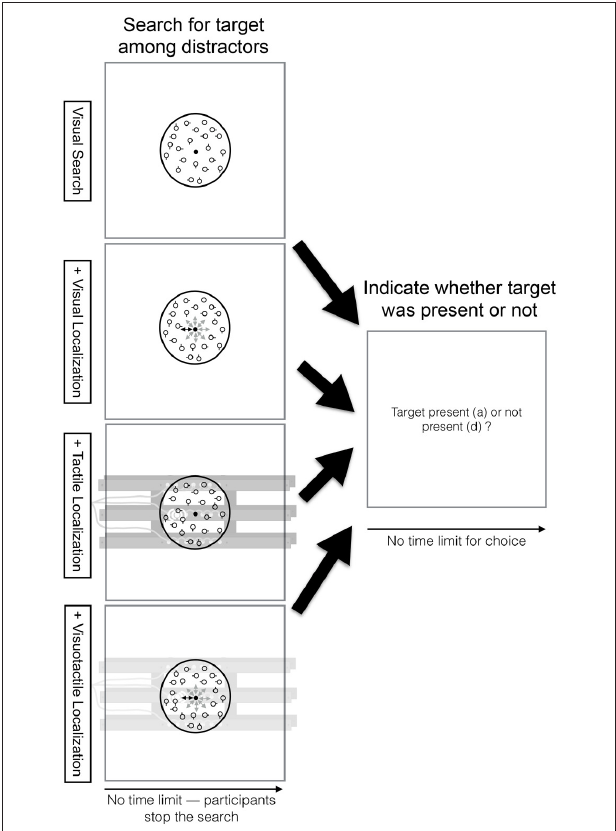
FIGURE 2 | Visual search task time course overview. Participants searched within a circle (2 visual degree diameter) in the center of the screen for a target among distractors (see top row, first column). Within the circle, there were always 20 circles (0.13 visual degrees radius) shown of which one was a target in 50% of the trials. Distractors differed from the target in one feature. They had an additional short line (0.05 visual degrees) attached to it (either at 0 ◦ , 90 ◦ , 180 ◦ , or 270 ◦ ). Participants could stop the search at any point in the trial by pressing the “s” key on the keyboard. Once participants pressed this key, they were required to indicate whether the target was present or not (see top row, second column). Participants did not receive feedback whether they answered this question correctly. The visual search task was performed in combination with the visual (2nd row), tactile (3rd row), or visuotactile localization task (4th row). Note that there was no limit for the location cues—location cues were received as long participants were searching. Yet, participants only performed the localization task while searching for the target among distractors. Once participants stop the search, they no longer need to do the localization task.